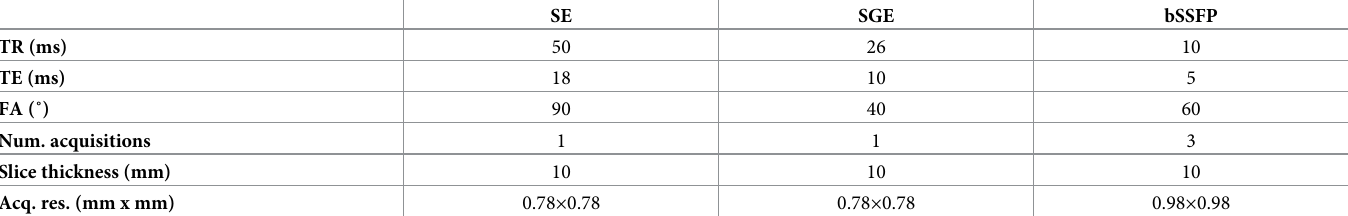
Table 2. Parameters of the MR sequences that were used to analyze the samples with different concentrations of ferumoxytol and gadoterate. Acq. res. = acquired resolution. SE SGE